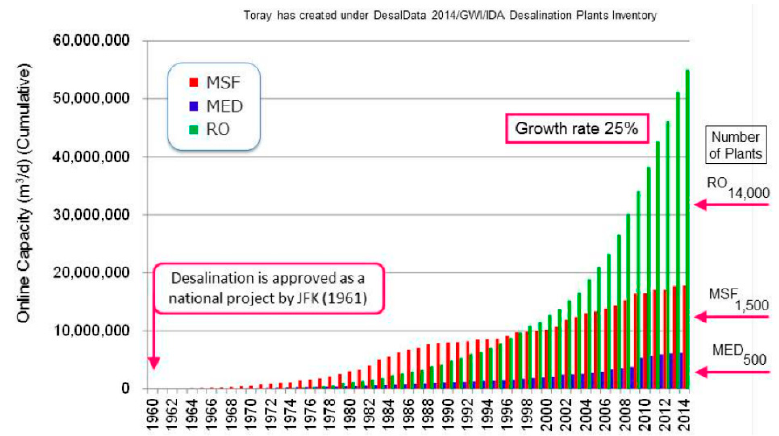
Figure 1. Online capacity of various desalination technologies and the expansion of the global desalination market [25].